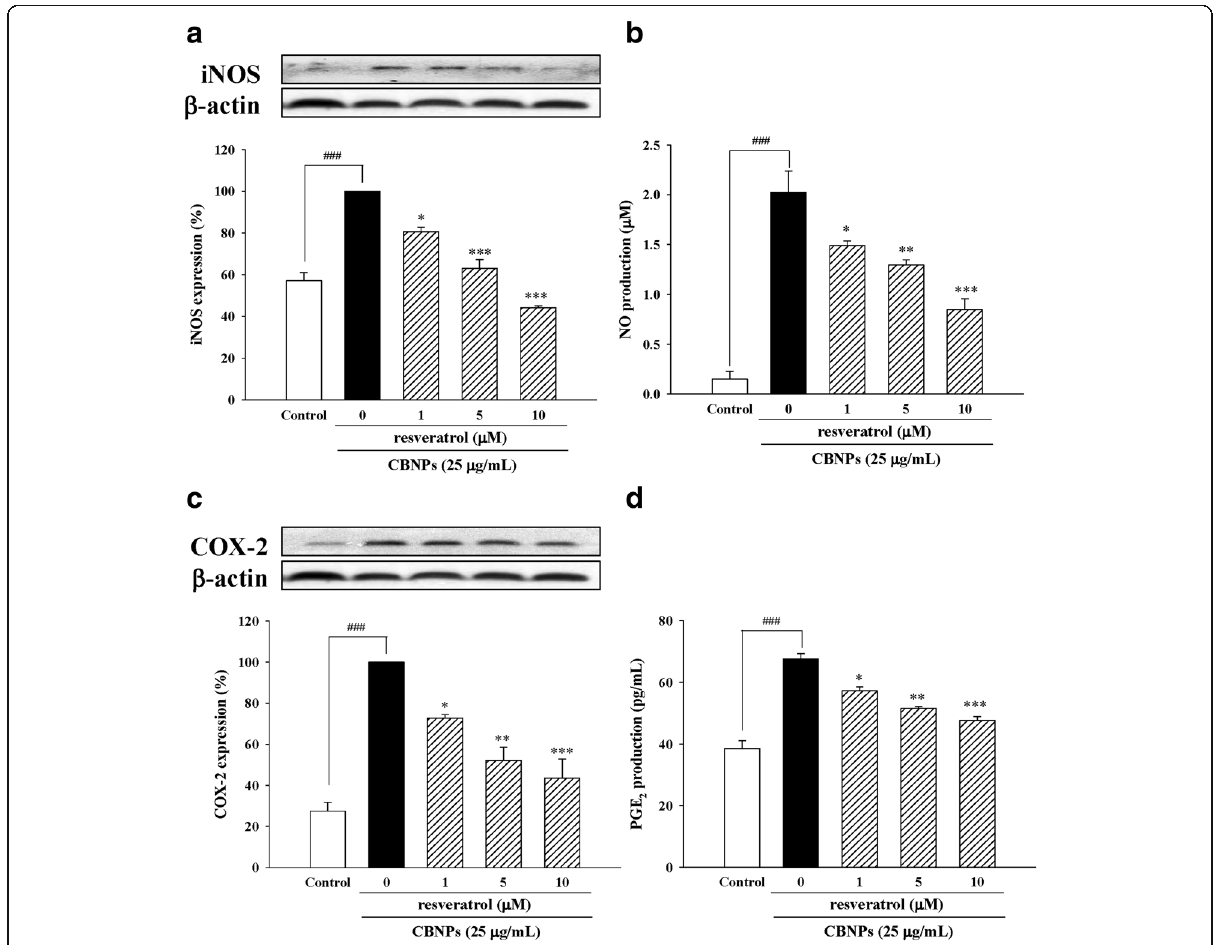
Fig. 7 Effects of resveratrol on iNOS expression ( a ), NO production ( b ), COX-2 expression ( c ), and PGE 2 production ( d ) in CBNPs-treated A549 cells. Cells were pre-treated with resveratrol for 1 h before addition of CBNPs (25 μ g/mL) for 24 h. Bars represent the mean ± S.E.M. from six independent experiments. ### P < 0.001 vs. control group (without any treatment). * P < 0.05, ** P < 0.01, *** P < 0.001 vs. CBNPs (25 μ g/mL)